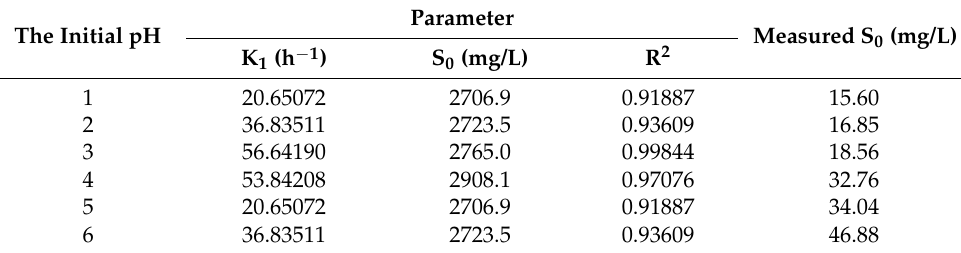
Table 4. The kinetic parameters under different initial pH values.